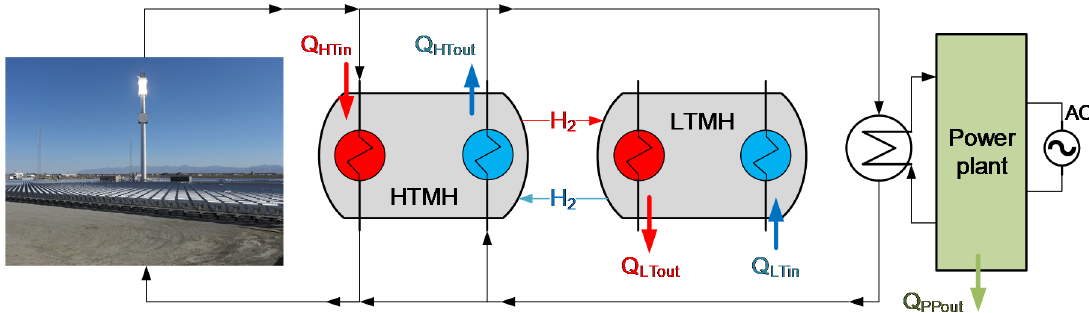
Figure 7. Concentrating solar power plant with thermal energy storage system based on coupled metal hydrides: a high temperature metal hydride (HTMH) exchanges hydrogen with a low temperature metal hydride (LTMH) to store and release thermal energy.